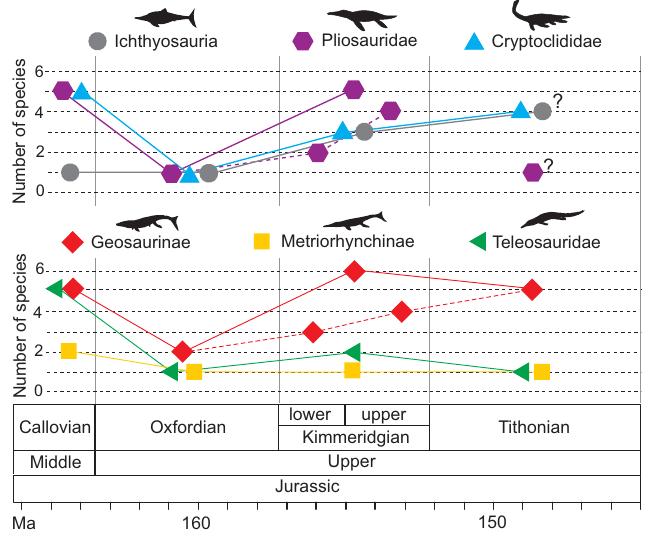
Fig. 15. Jurassic Sub-Boreal Seaway marine reptile species